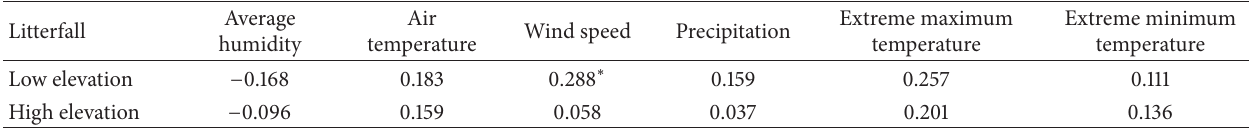
Table 4: The relationships between litterfall and climate factors at two